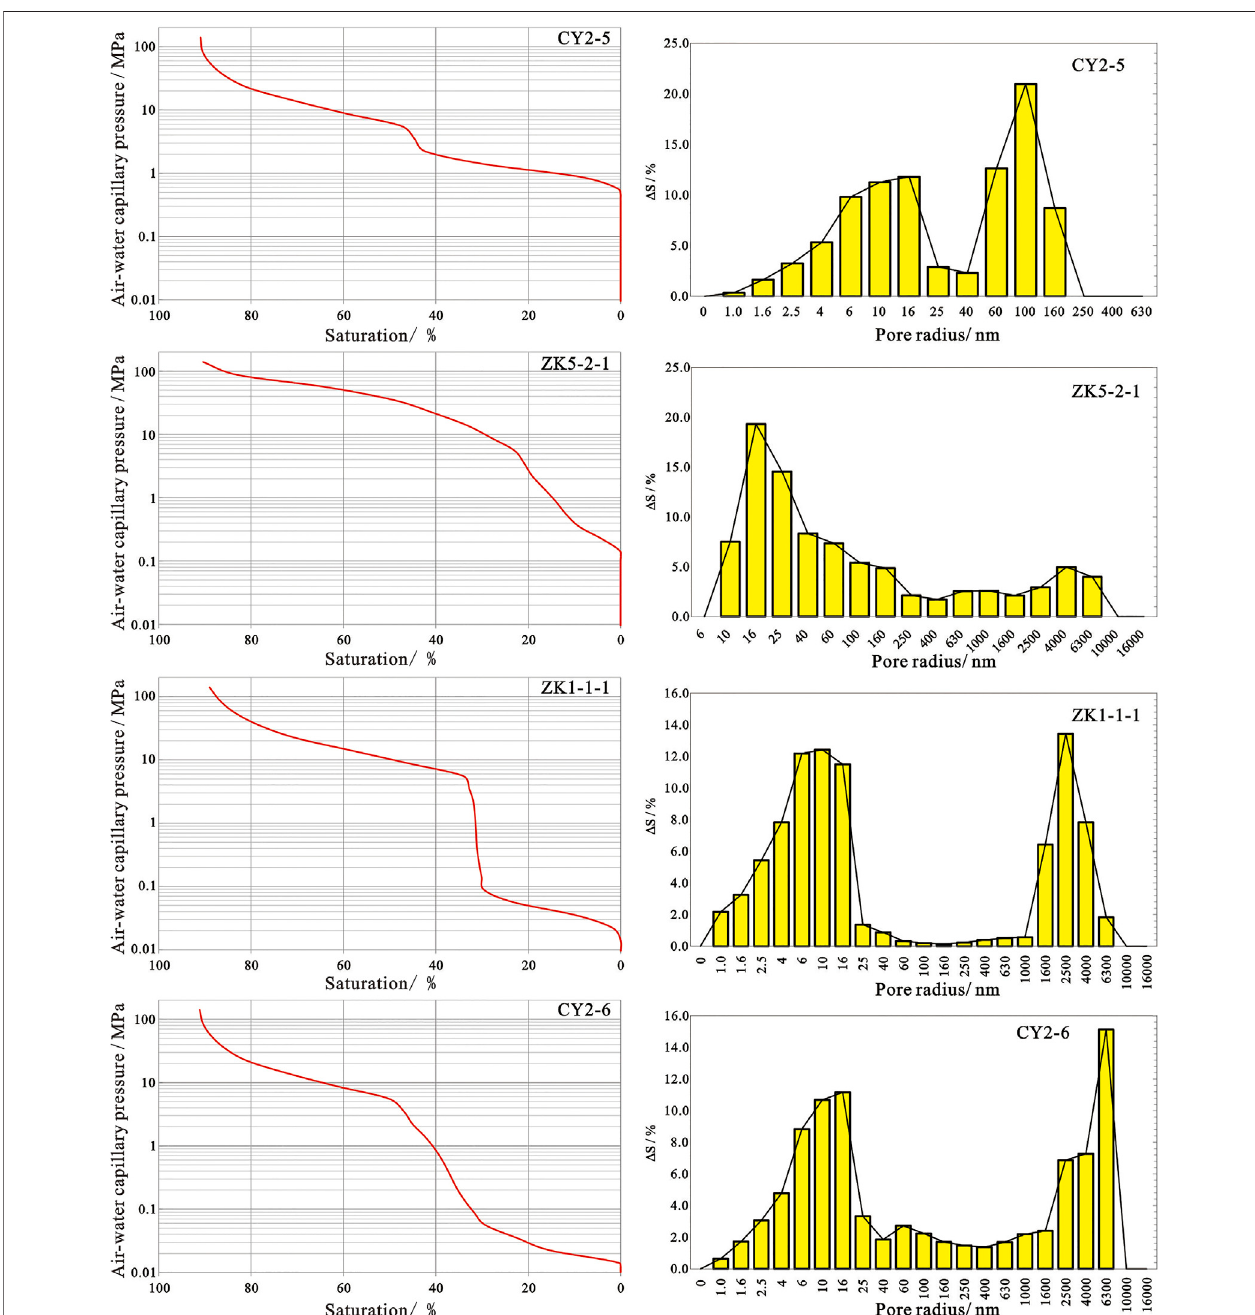
FIGURE 9 | Joint test of low-pressure gas (N 2 ) adsorption and MICP as well as converted pore size distribution.